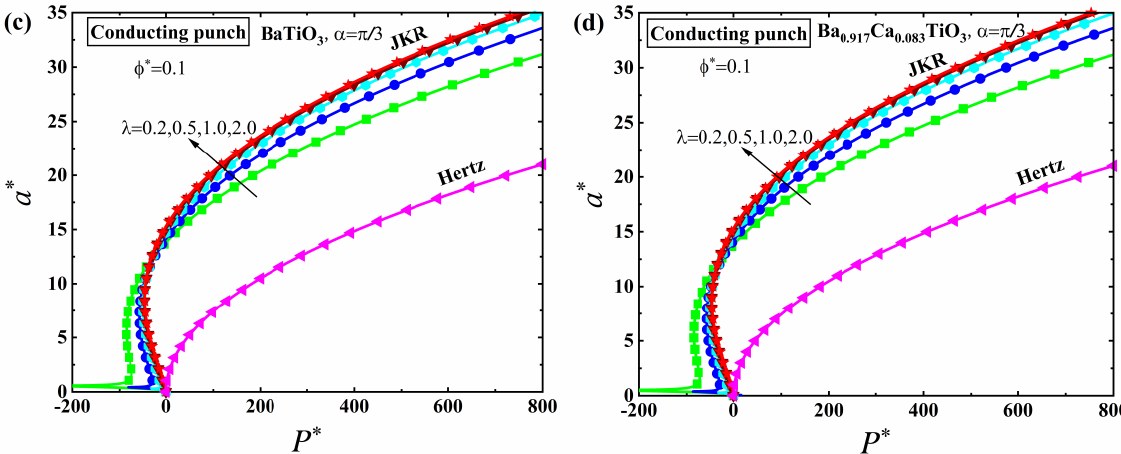
Figure 16. The dimensionless indentation force, P ∗ , as a function of the dimensionless indentation depth, h ∗ , under the action of a conducting punch for the M-D model. ( a ) PZT-4. ( b ) PZT-5A. ( c ) BaTiO 3 . ( d ) Ba 0.917 Ca 0.083 TiO 3 .